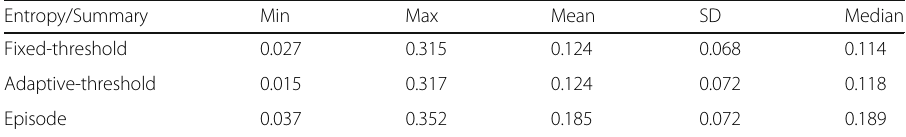
Table 2 Summary statistics for the distribution across HRRs of mean entropy (taken over six 1-year windows) for the three different ways of constructing